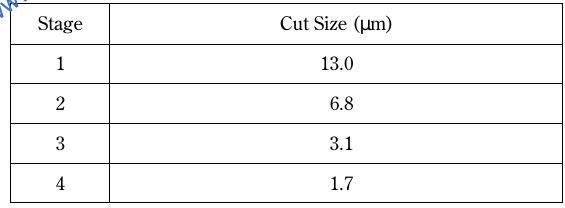
Table 7 Stage d 50 values for the multi-stage liquid impinger at 60 L/min